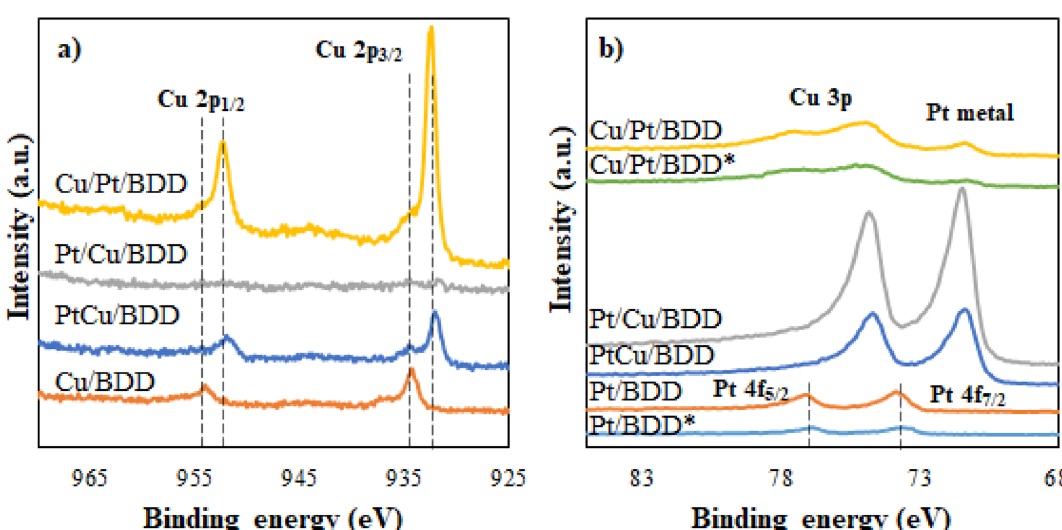
Figure 4. XPS spectra for ( a ) Cu 2p and ( b ) Pt 4f of the modified electrodes [Pt/BDD, Cu/BDD, PtCu/BDD, Pt/ Cu/BDD, and Cu/Pt/BDD fabricated by multiple-step deposition; Pt/BDD* and Cu/Pt/BDD* fabricated by one- step deposition of Pt and Cu,